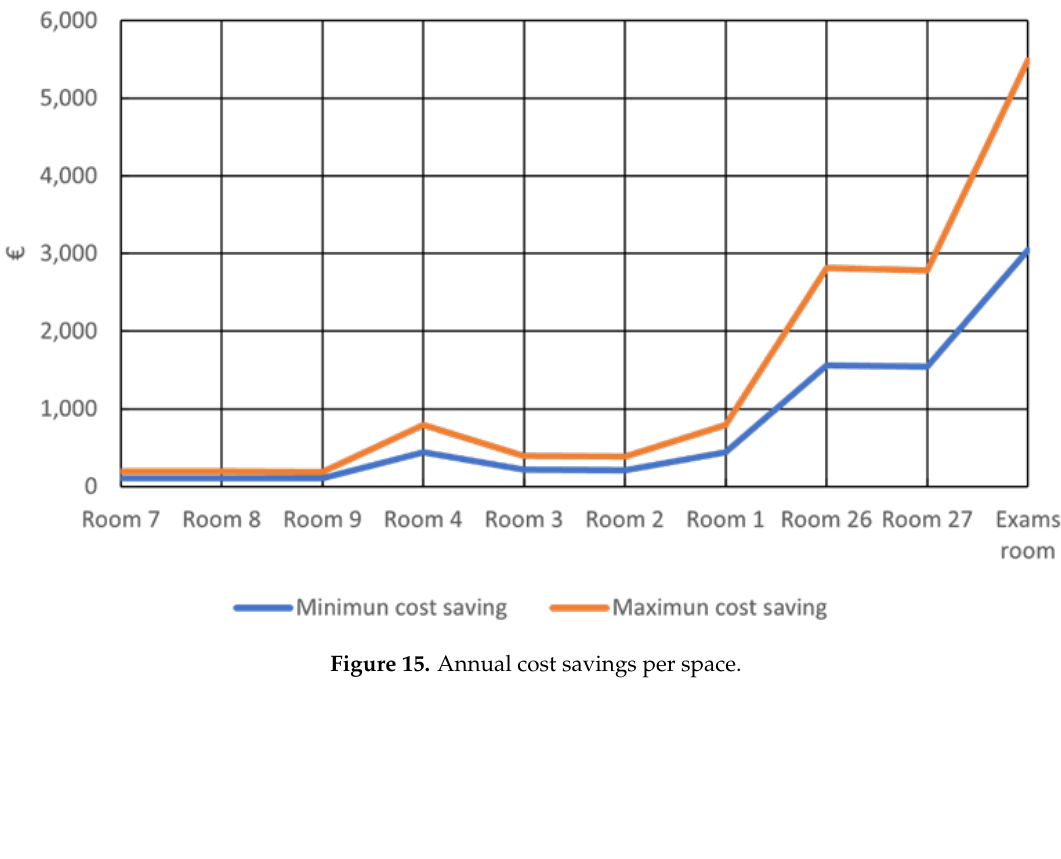
Figure 14. Annual consumption savings per space.